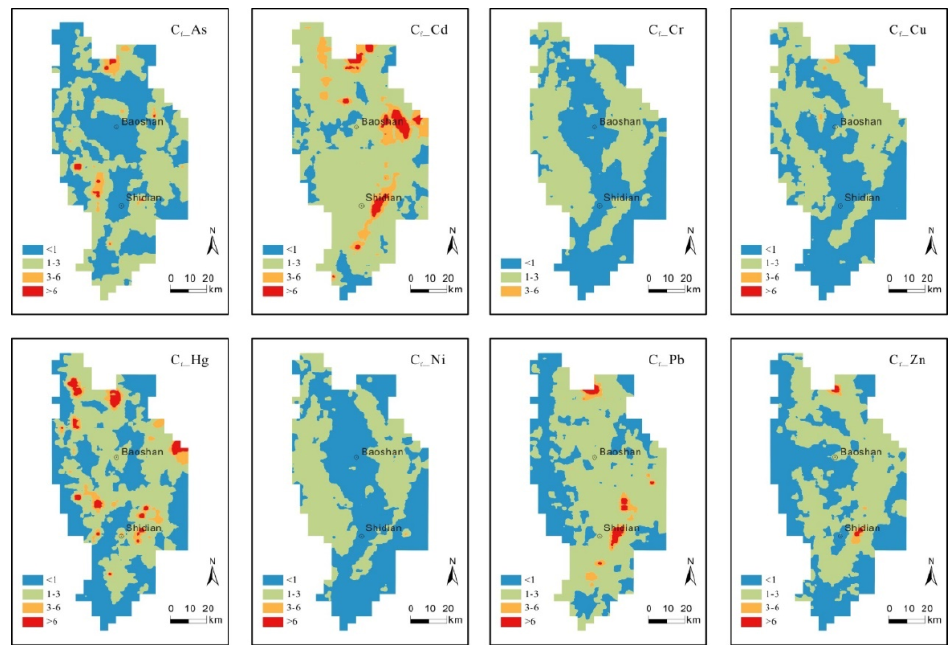
Figure 5. The distribution of counter maps of the contamination factor (C f ) determined by inverse distance-weighted (IDW)